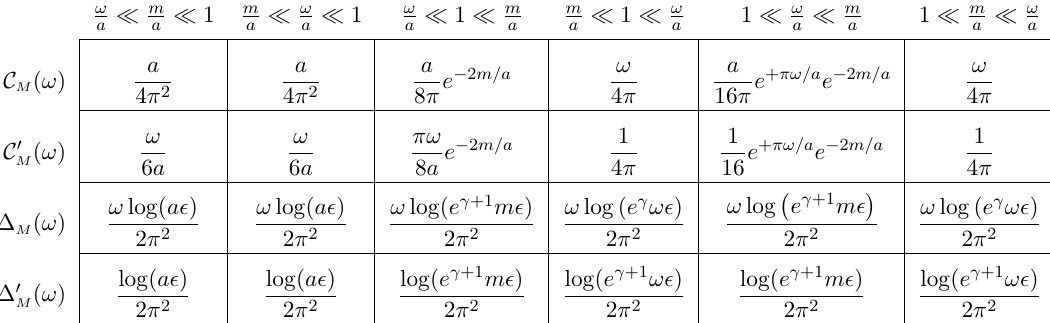
Table 1 . Leading-order behaviour for the various functions C of relative sizes of ! , m and a , where primes denote di(cid:11)erentiation with respect to ! . Only the divergent part of (cid:1) and (cid:1) 0 are quoted (see appendix D for their derivations for the behaviour M M of (cid:1) and (cid:1) 0 ). (cid:13) denotes the Euler-Mascheroni M M